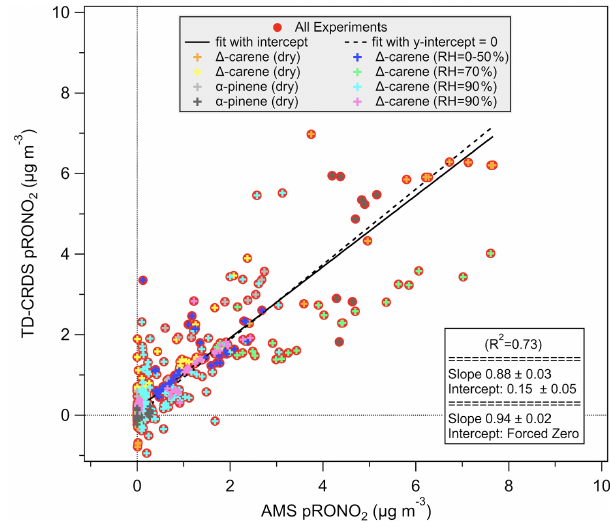
Figure 8. Background and denuder-breakthrough-corrected aerosol-phase ANs measured by the TD-CRDS, compared to the high-resolution AMS organic-nitrate aerosol mass loading. Fits are orthogonal distance regression